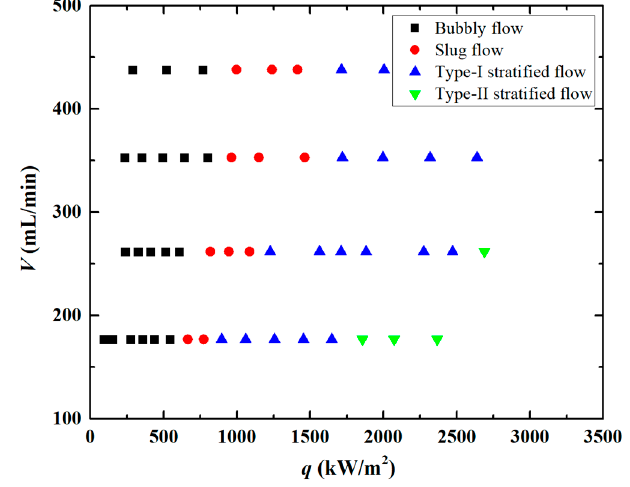
Figure 6. Flow operational map during flow boiling in NMC.